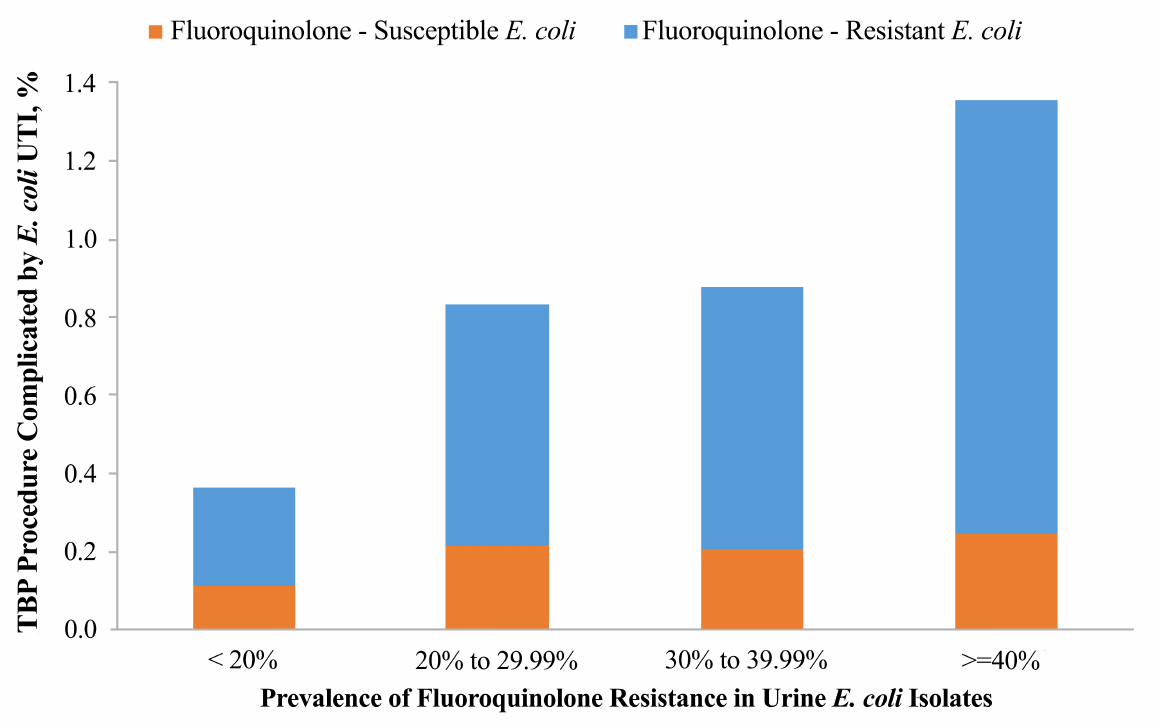
Figure 3. Facility Fluoroquinolone-Resistant Escherichia coli Urinary Tract Infections Following Transrec- tal Biopsy of the Prostate and Fluoroquinolone Resistance in All Urinary E.